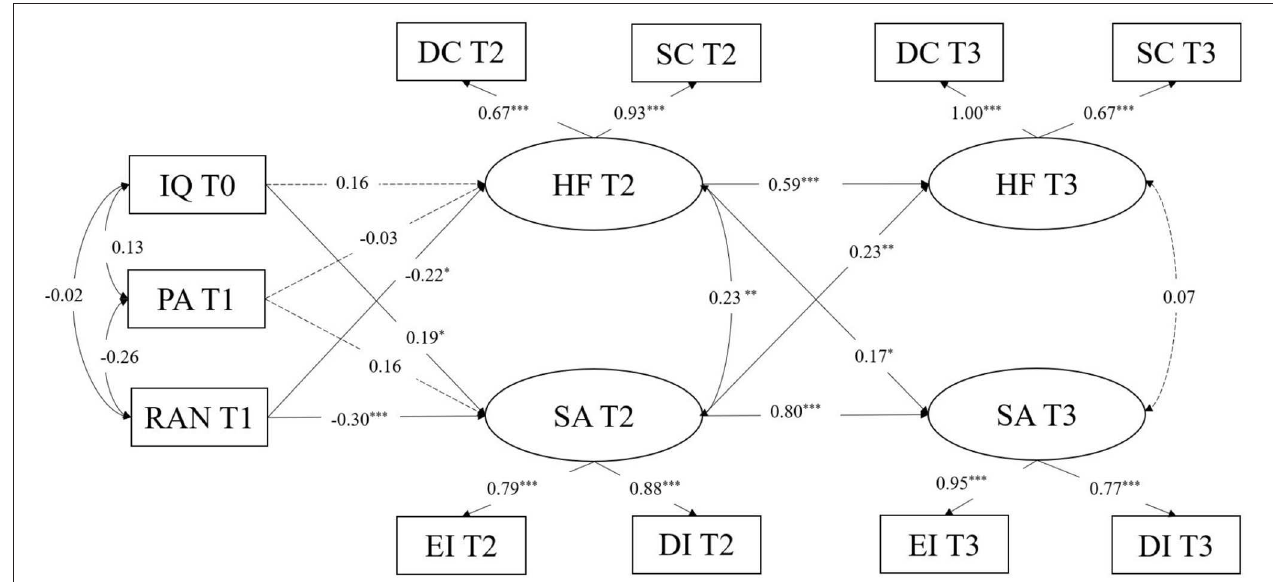
FIGURE 1 | The cross-lagged analysis for handwriting fluency (HF) and spelling accuracy (SA). IQ, Raven’s Standard Progressive Matrices; PA, Phonological awareness; RAN, Rapid automatized naming; DC, Digit copying fluency task; SC, Sentence copying fluency task; EI, Easy items dictation task; DI, Difficult